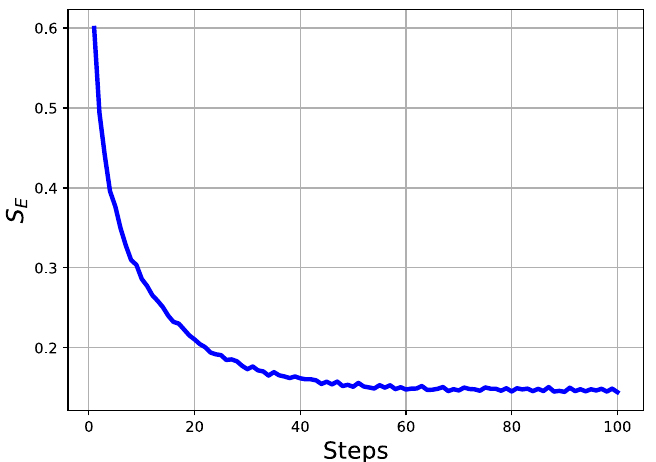
Figure 2. The result of running a set of 200 independent simulations where the entropy of the matrix E (Eq. 16) is calculated at each time point and the average across the traces is presented. With the passage of time it can